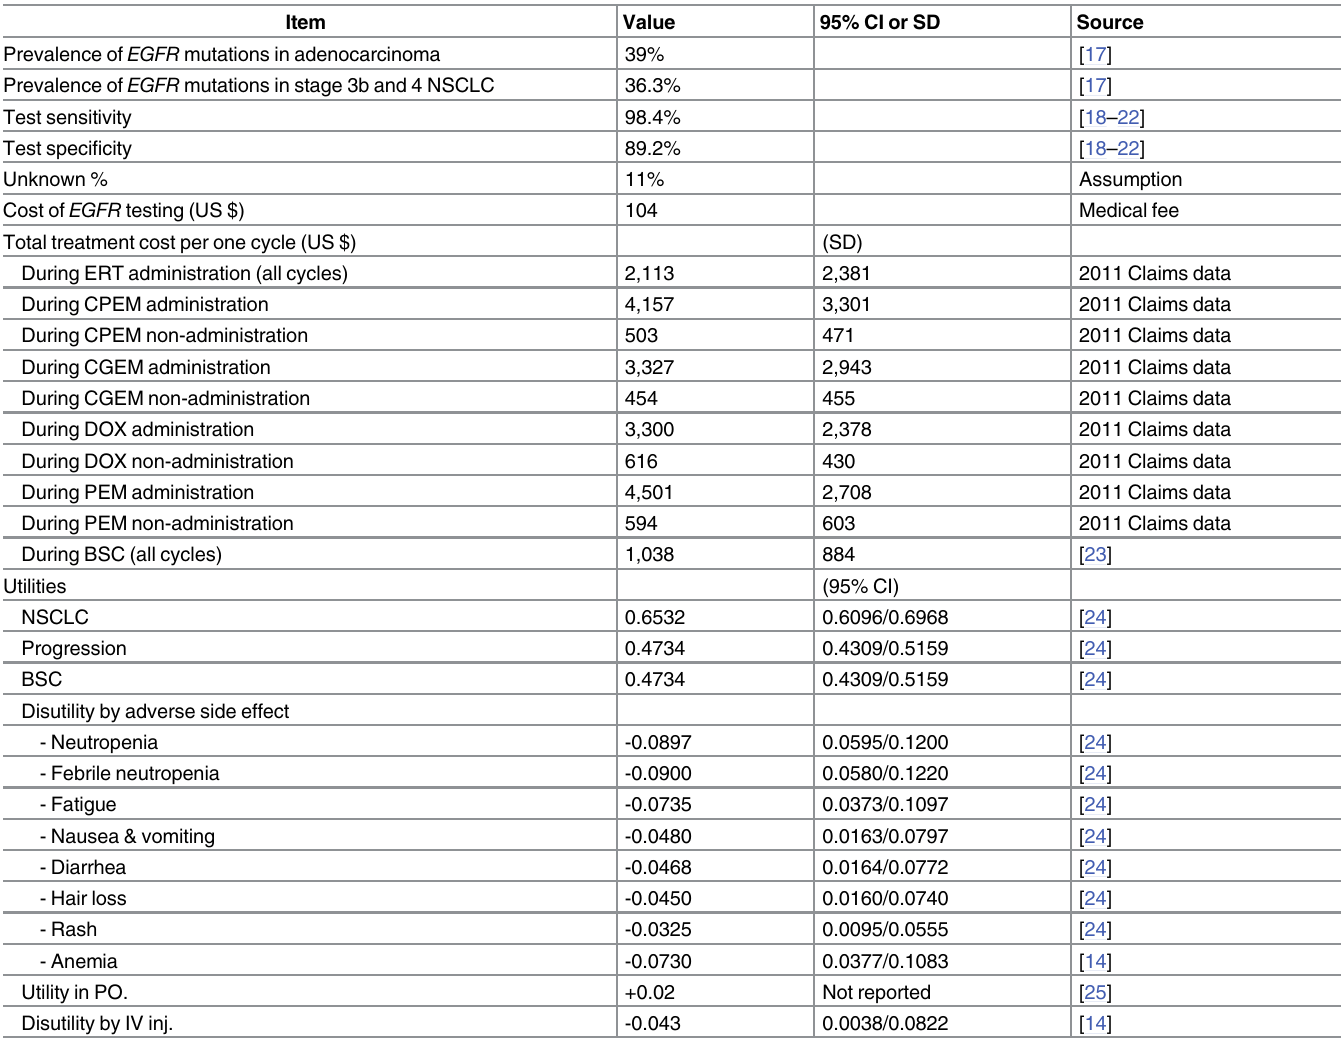
Table 1. Input parameters.